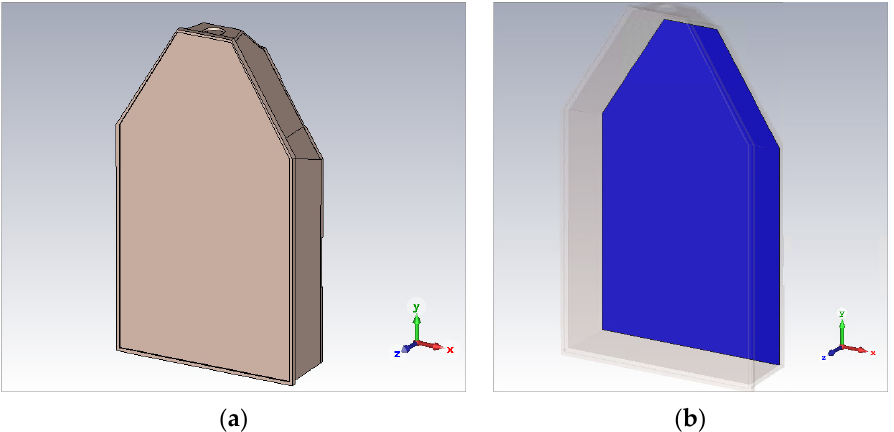
Figure 10. Projection of the T175 culture flask: ( a ) non-transparent, ( b ) transparent—with a visible thin layer of biological material.